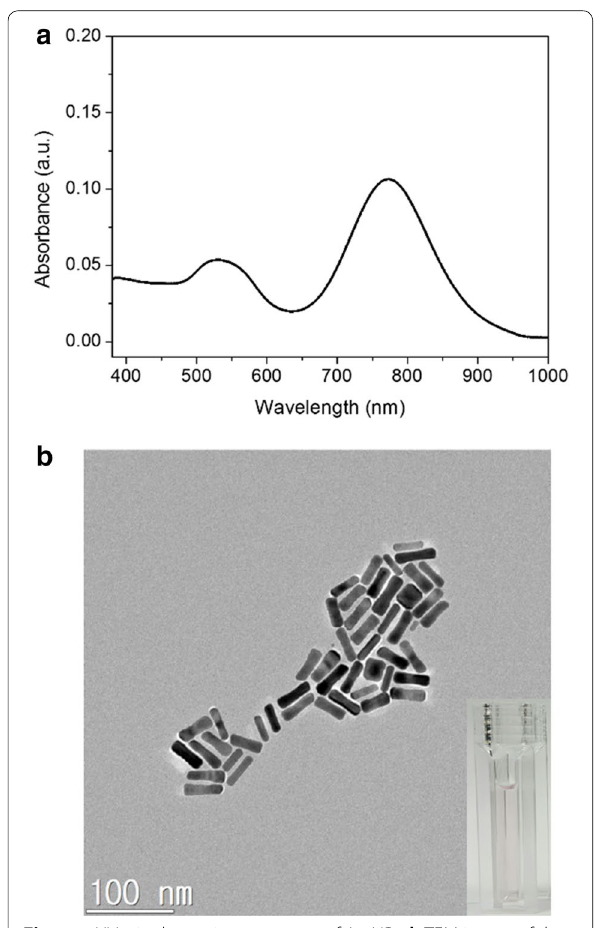
Au NRs. (Inset: photograph of the Au NR colloid